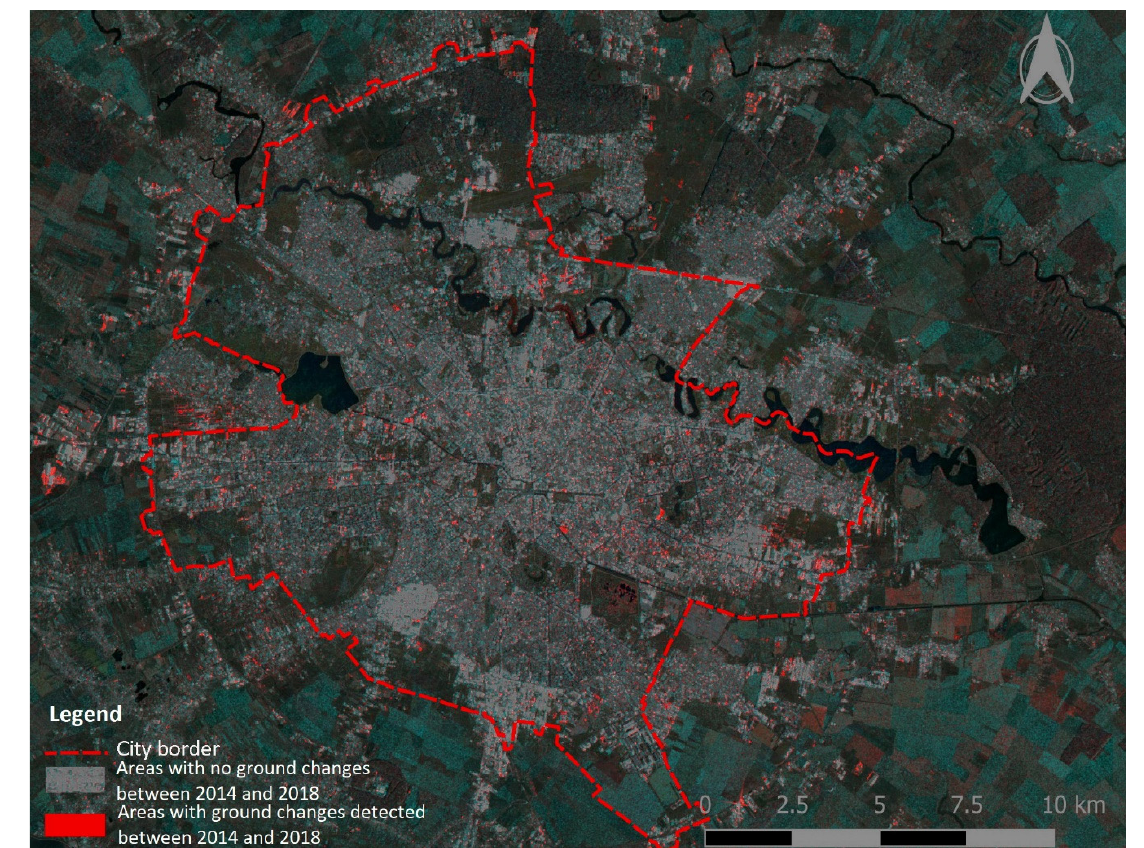
Figure 5. Detection map of land surface changes for Bucharest (2014–2018), obtained from Sentinel-1 GRD images (modified after [28]). Gray tones symbolize areas where no changes were detected between 2014 and 2018. Areas where ground changes occurred between 2014 and 2018 are symbolized in red. Water bodies are shown on the map in dark tones. Map generated using ESA SNAP (Sentinel Application Platform) and QGIS open-source software. Source: elaborated by the authors.